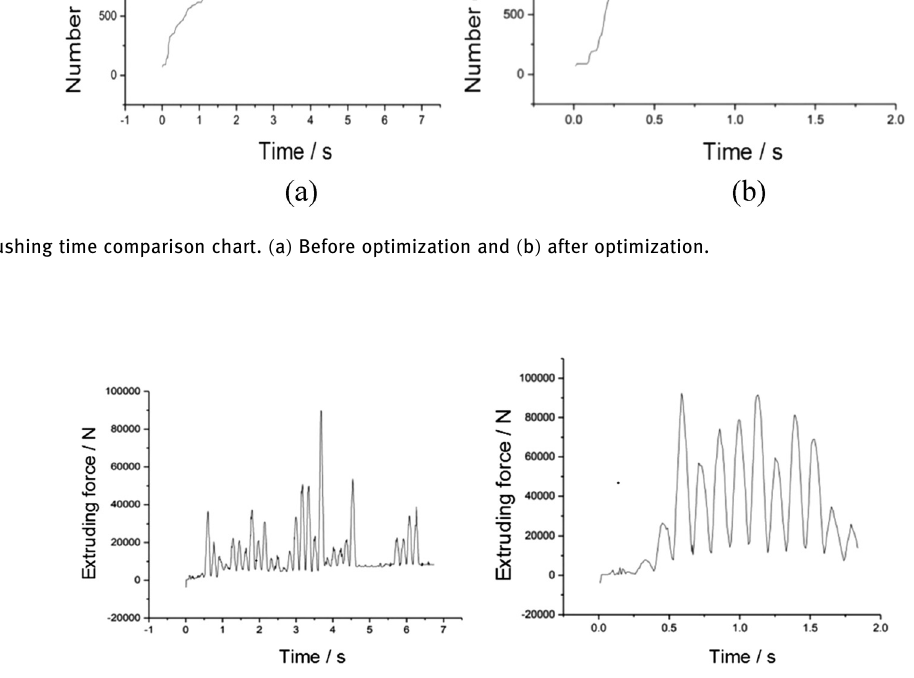
Figure 11: Maximum crushing force comparison chart. ( a ) Before optimization and ( b ) after optimization.